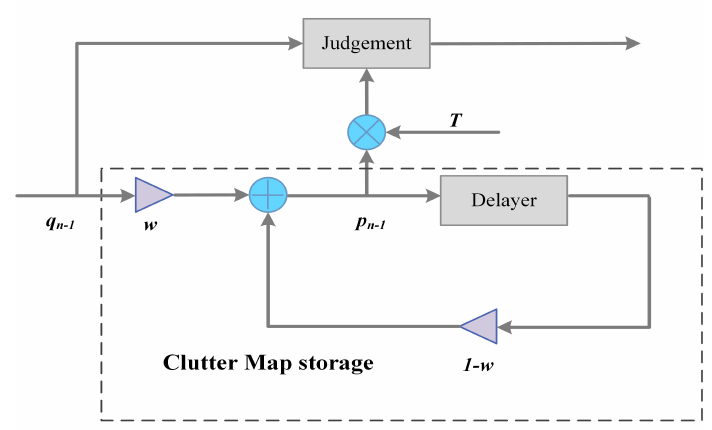
Figure 4. Clutter map processor